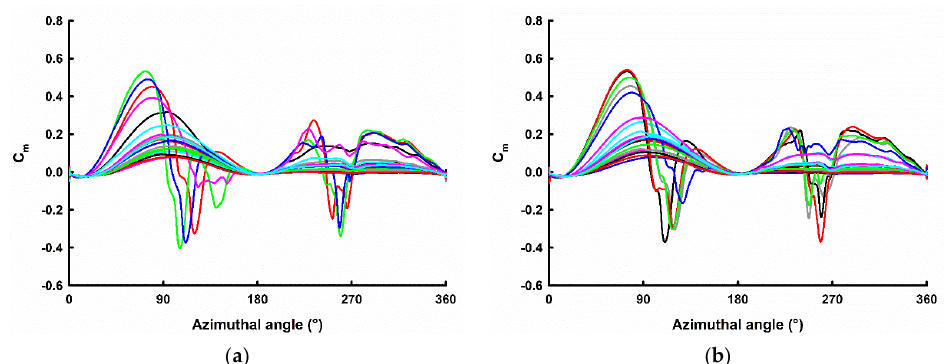
Figure 24. Variation of Coefficient of Moment (C m ) with azimuthal angle for gust time periods ( a ) 3 s; ( b ) 10.5 s. Coefficient of Moment at various time instances (rotational cycles) are represented through different coloured lines. Due to randomized wind conditions, values vary every rotational cycle.